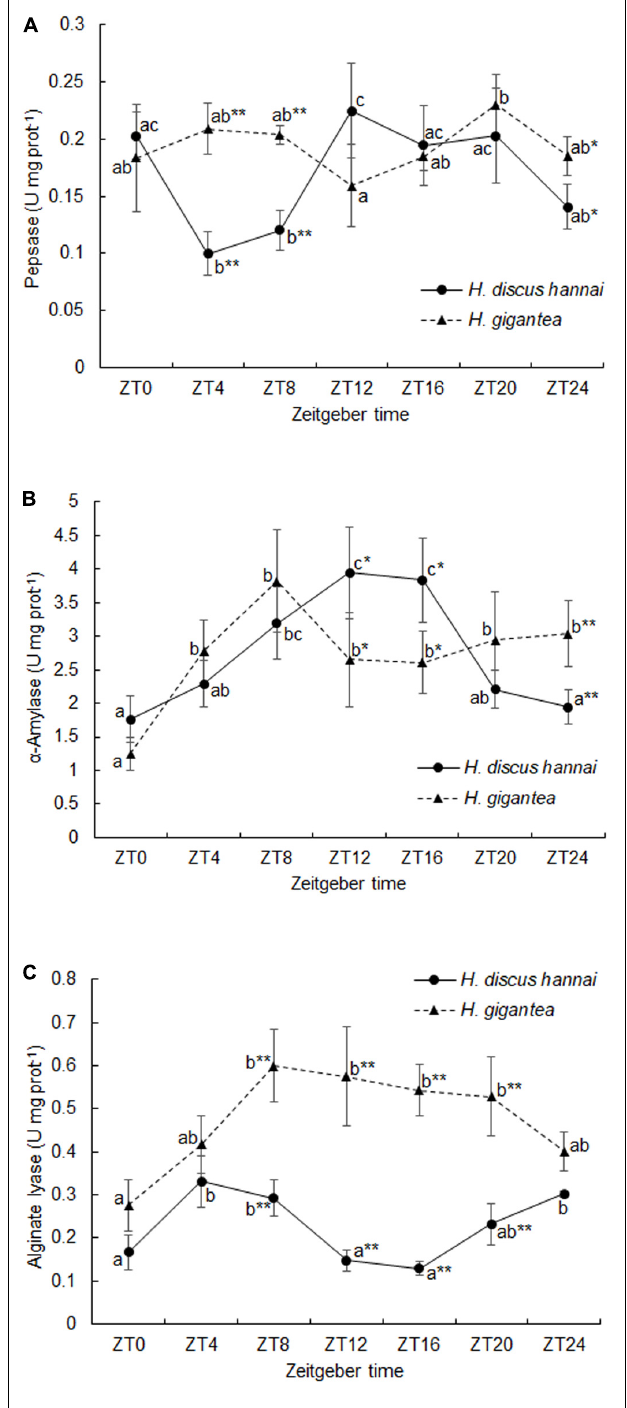
FIGURE 3 | Activities of pepsase (A) , α -amylase (B) , and alginate lyase (C) in Haliotis discus hannai and Haliotis gigantea . Values are expressed as mean ± SE ( n = 4). Treatments with different letters are significantly different at different sampling times in the same species ( P < 0.05). “*” and “**” indicate significant differences at P < 0.05 and P < 0.01, respectively, in the digestive enzyme activity levels at the same sampling time in different species. No label indicates no significant difference at P < 0.05 in the digestive enzyme activity levels at the same sampling time in the same